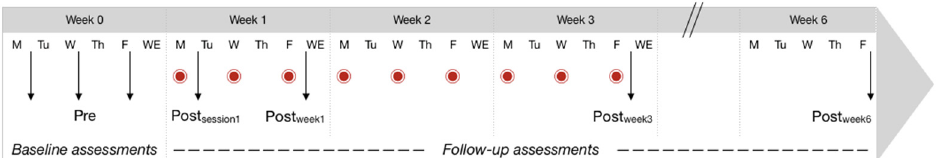
Figure 1. HEMISTIM protocol design. Red circle symbols indicate experimental sessions. Assessment periods are indicated by vertical arrows.